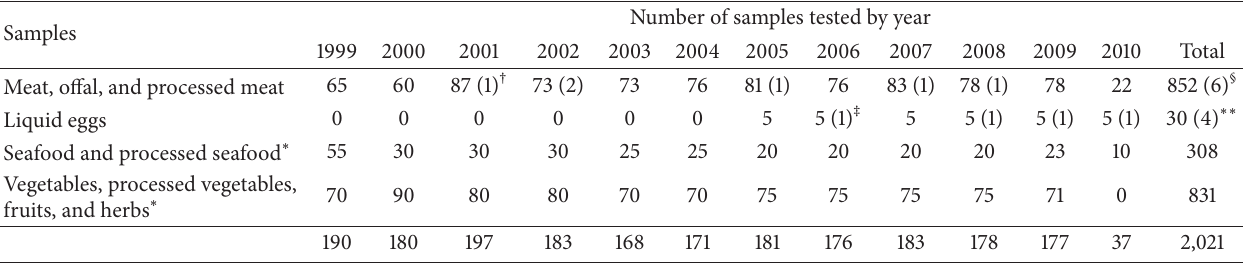
Table 1: Prevalence of Salmonella in retail food samples from Fukuoka Prefecture.